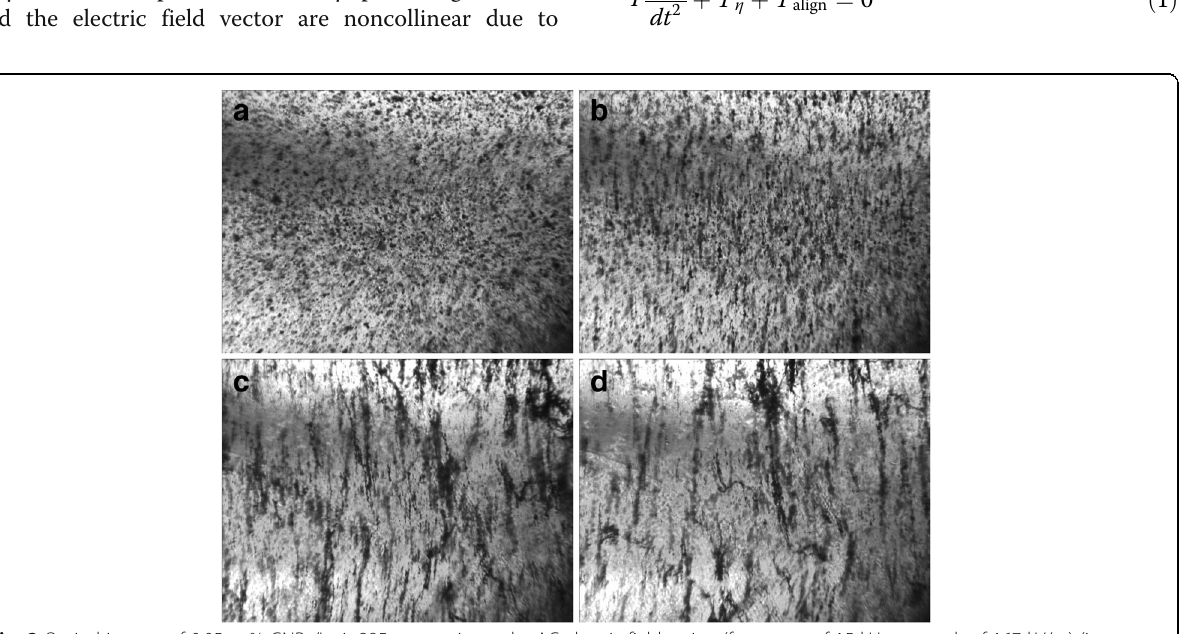
Fig. 2 Optical images of 0.05 wt% GNPs/Larit 285 composite under AC electric field action (frequency of 15 kHz, strength of 167 kV/m) (in capacitor): а — before electric field action; b — after 12 min; c — after 26 min; d — after 60 min of electric field action. Image size 10.8 × 8.0 mm